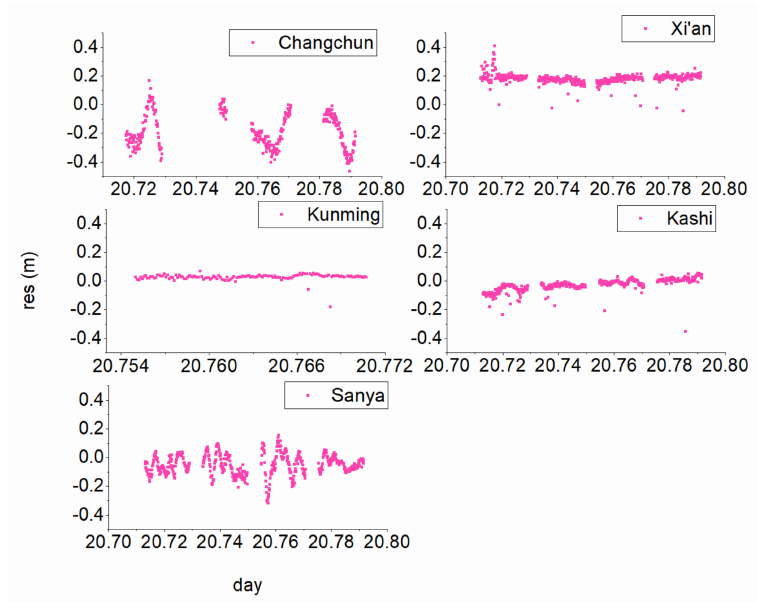
Figure 5. The residuals of five stations of the ODTT system.